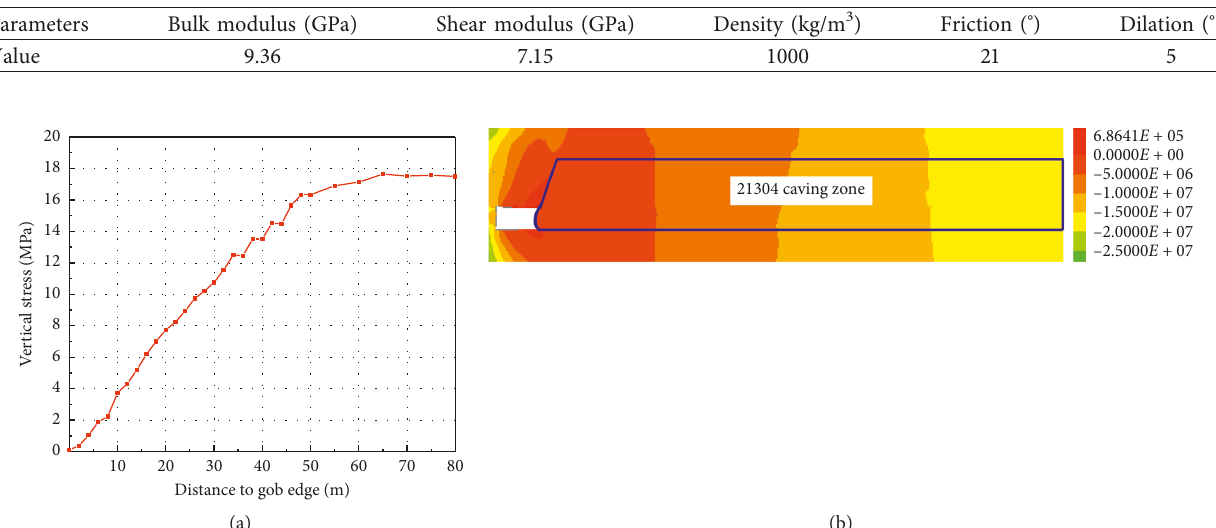
Table 5: Material parameters for the gob model.